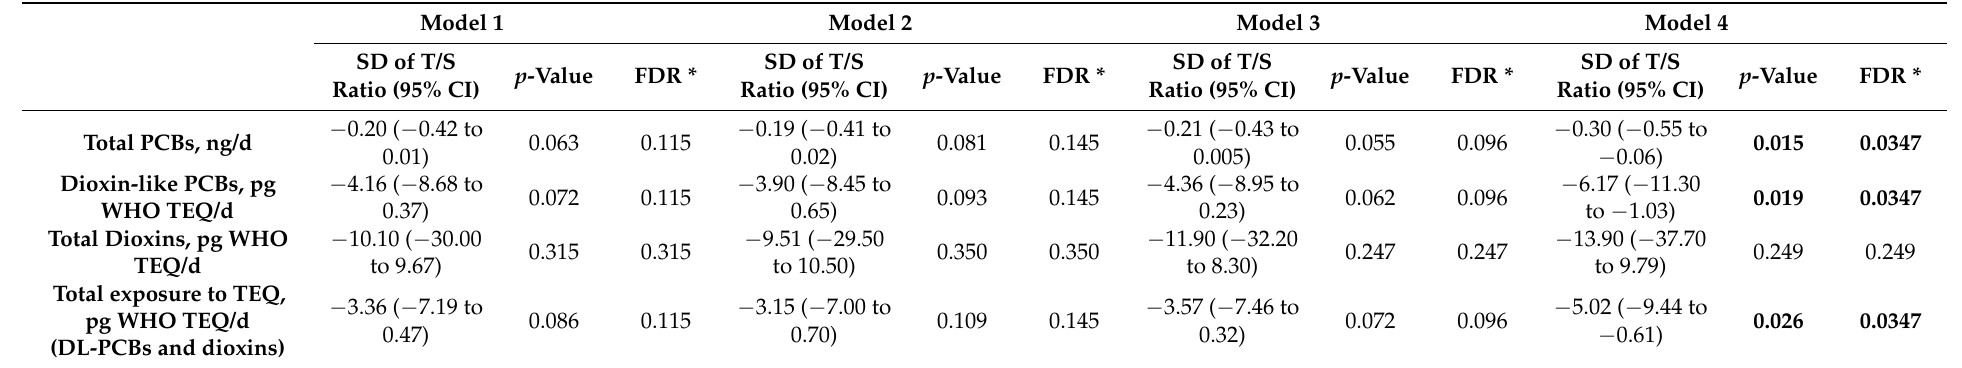
Table 2. Multivariable regression models of relative telomere length (SD of T/S ratio) and dietary exposure to PCBs and dioxins of participants over 55 years from the SUN